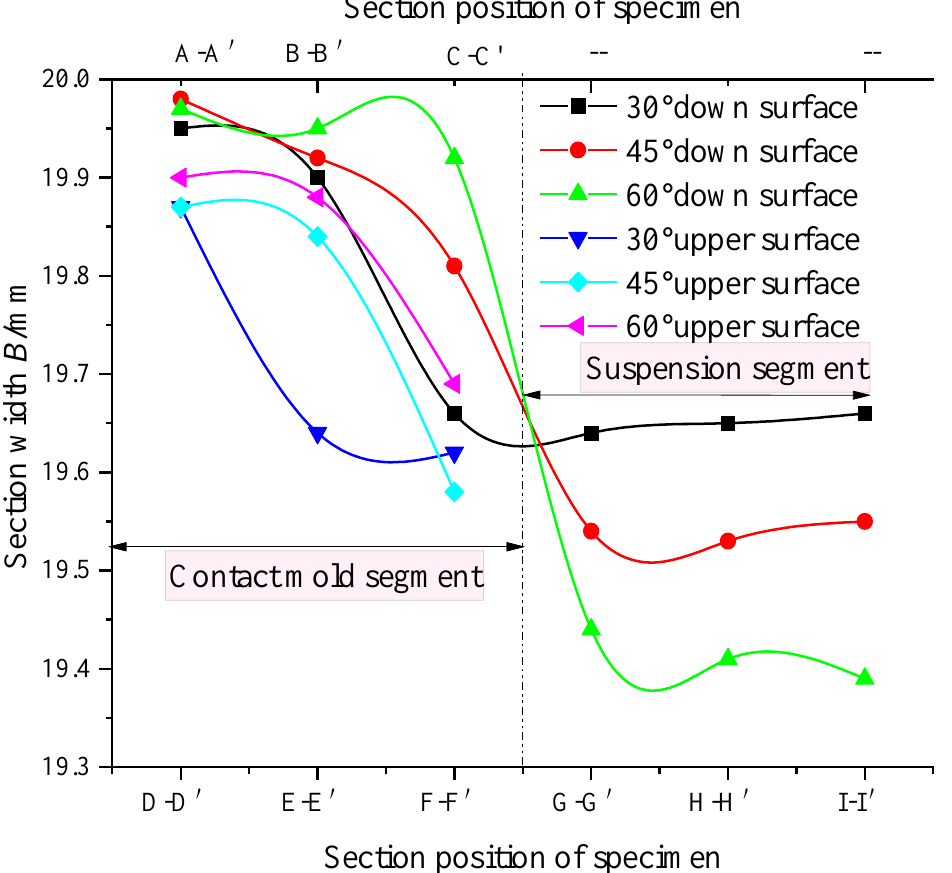
Figure 11. Variation curves of the upper and lower edges of the specimen cross-section with smooth die stretch-bending.